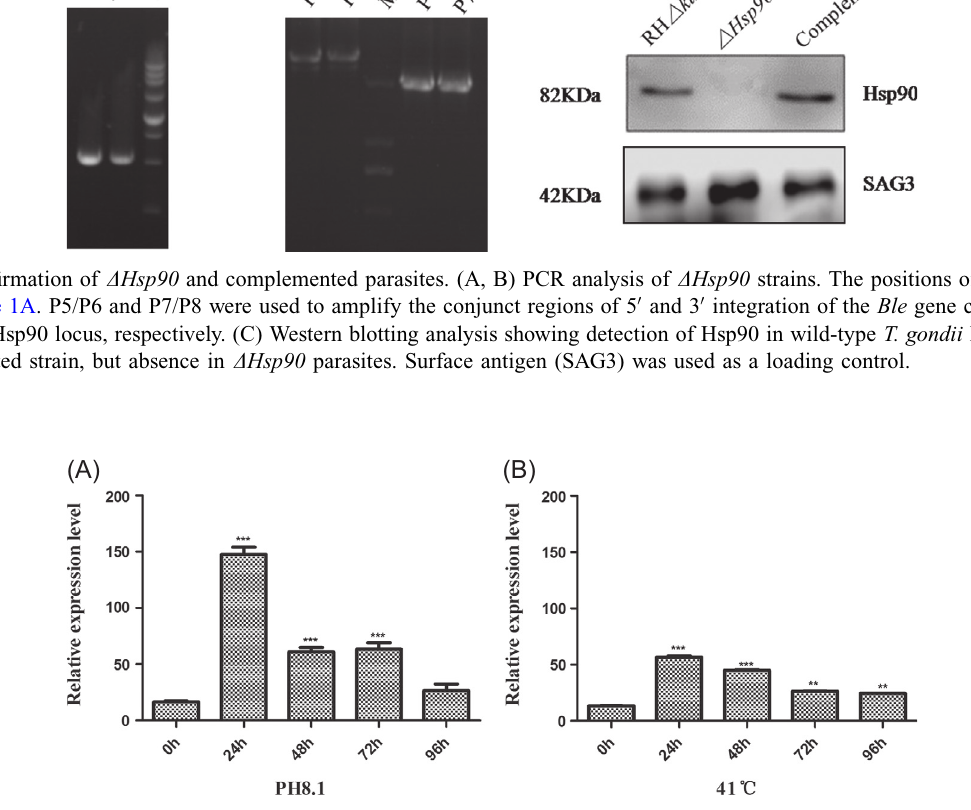
Figure 3. Real-time RT-PCR of Hsp90 transcriptional level during bradyzoite differentiation in vitro . The RH D ku80 T. gondii cells were exposed to alkaline treatment (pH 8.1) (A) or heat shock (41 (cid:3) C) (B) for 0, 24, 48, 72 or 96 h. Total RNA was purified from the bradyzoites collected at the end of each time point. The expression levels were determined by real-time RT-PCR using actin as an internal control. Samples collected at 24, 48, 72 or 96 h were compared to those at time 0 h. ‘‘***’’ indicate a statistically significant difference ( p < 0.001). Values represent mean ± SD , n = 3 experiments.